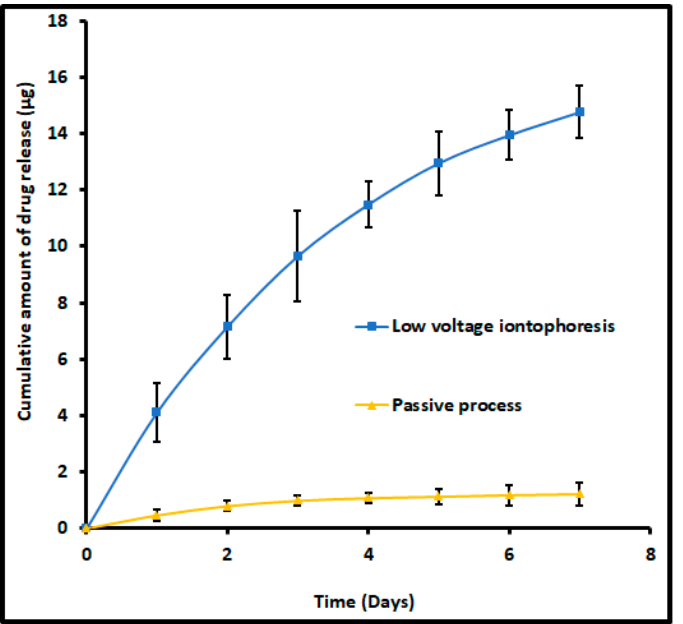
Figure 12. Comparison of the amount of terbinafine release into the receiver from drug-accumulated nails by low voltage iontophoresis (F8) and passive process (control). The drug accumulation into the nail tissue was done with an optimized batch (F8) using iontophoresis (12 V for 6 h) and a passive process (0 V for 6 h). The data represents mean ± SD ( n = 6).